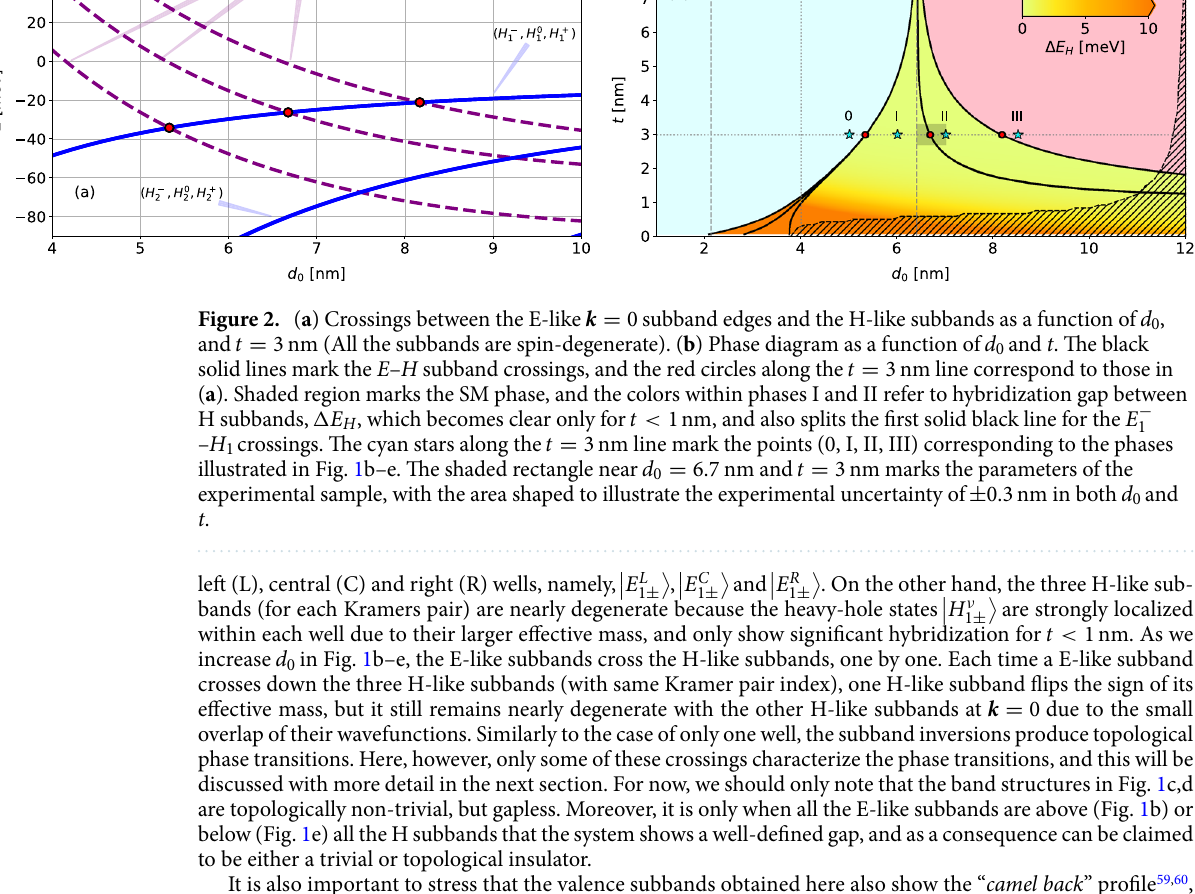
Figure 2. ( a ) Crossings between the E-like k 3 nm (All the subbands are spin-degenerate). ( b ) Phase diagram as a function of d 0 and t . The black and t = solid lines mark the E – H subband crossings, and the red circles along the t ( a ). Shaded region marks the SM phase, and the colors within phases I and II refer to hybridization gap between H subbands, (cid:31) E H , which becomes clear only for t < 1 nm, and also splits the first solid black line for the E − 1 – H 1 crossings. The cyan stars along the t illustrated in Fig. 1b–e. The shaded rectangle near d 0 experimental sample, with the area shaped to illustrate the experimental uncertainty of t left (L), central (C) and right (R) wells, namely, (cid:31) bands (for each Kramers pair) are nearly degenerate because the heavy-hole states (cid:31) within each well due to their larger effective mass, and only show significant hybridization for t < 1 nm. As we